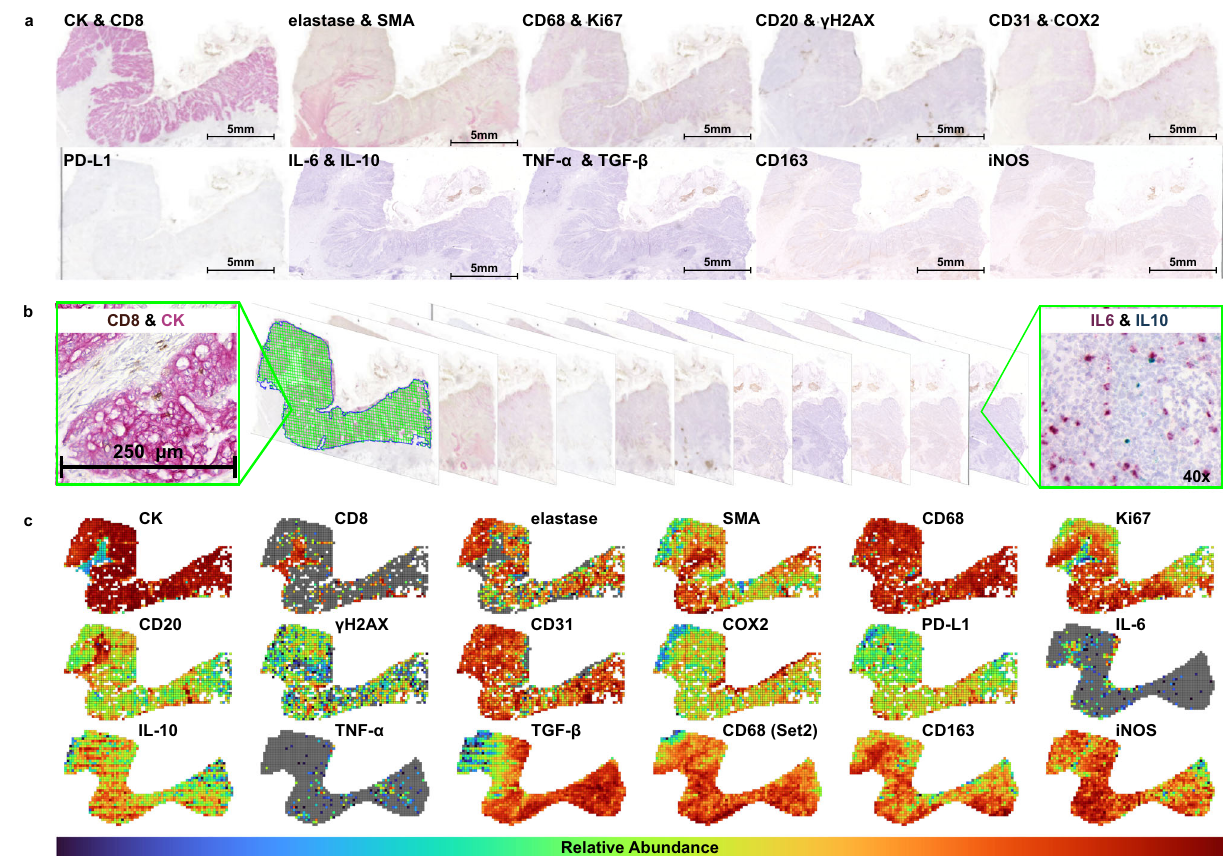
Fig. 4 Example of a single sample used to describe the tumor ecology. a To describe the spatial distribution of cell types and gene expression, 10 serial slices were taken from each sample and each stained with one or two markers. There were two sets of serial slices, one with CK, CD8, elastase, SMA, CD68, Ki67, CD20, γ H2AX, CD31, COX2, and PD-L1. The second set included IL-6, IL-10, TNF- α , TGF- β , CD163, CD68, and iNOS. b After aligning the images in the two sets, each slice was divided into quadrats of 250 μ m × 250 μ m, and stain segmentation was performed to determine the abundance of each marker at ×40 magni fi cation. c Quadrat counts for all 18 markers in one colorectal carcinoma (CRC) sample (there are 17 unique markers, but CD68 is in both Set 1 and Set 2). The same process was repeated for n = 12 colorectal adenomas (CRA), n = 26, “ carcinoma-in-adenoma ” (CIA), and n = 15 CRC, using the fi rst set of markers, and for n = 9 CRA, n = 9 CIA, and n = 9 CRC using the second set of markers. This process was repeated for all